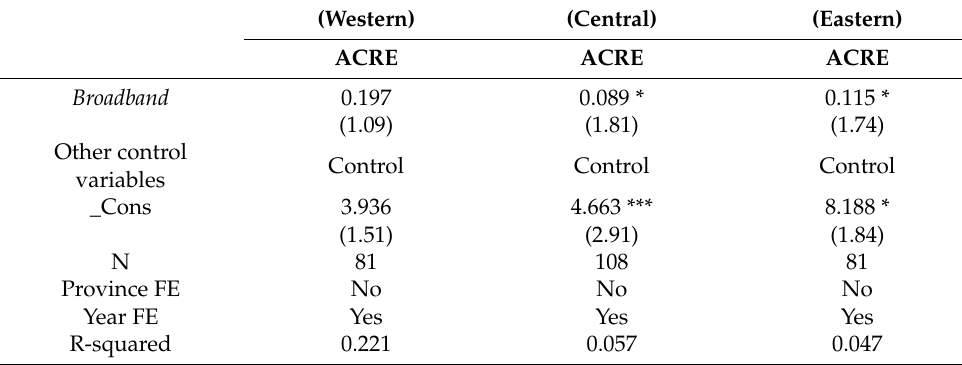
Table 9. Heterogeneity analysis